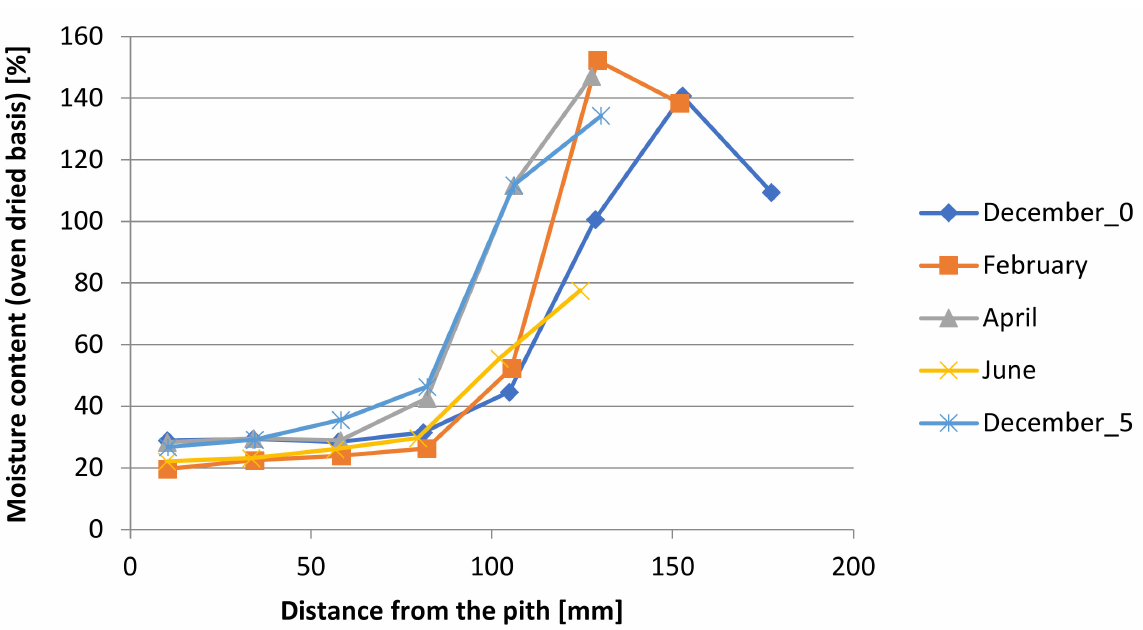
Figure 2. Moisture content in dependence on distance from the pith and during 6-month-long storage.